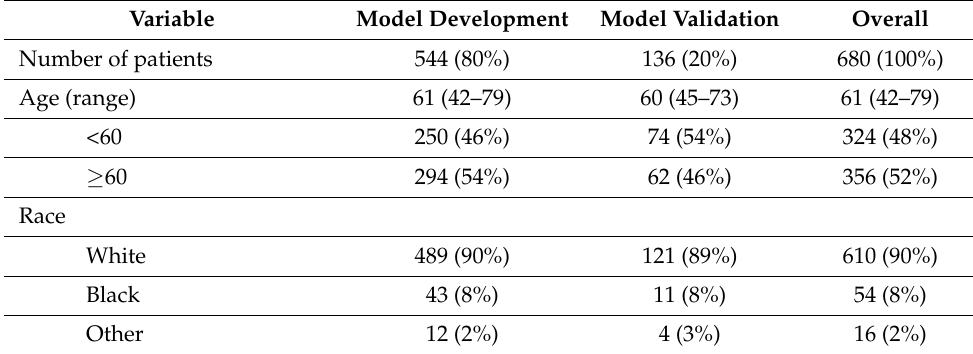
Table 1. Baseline Patient